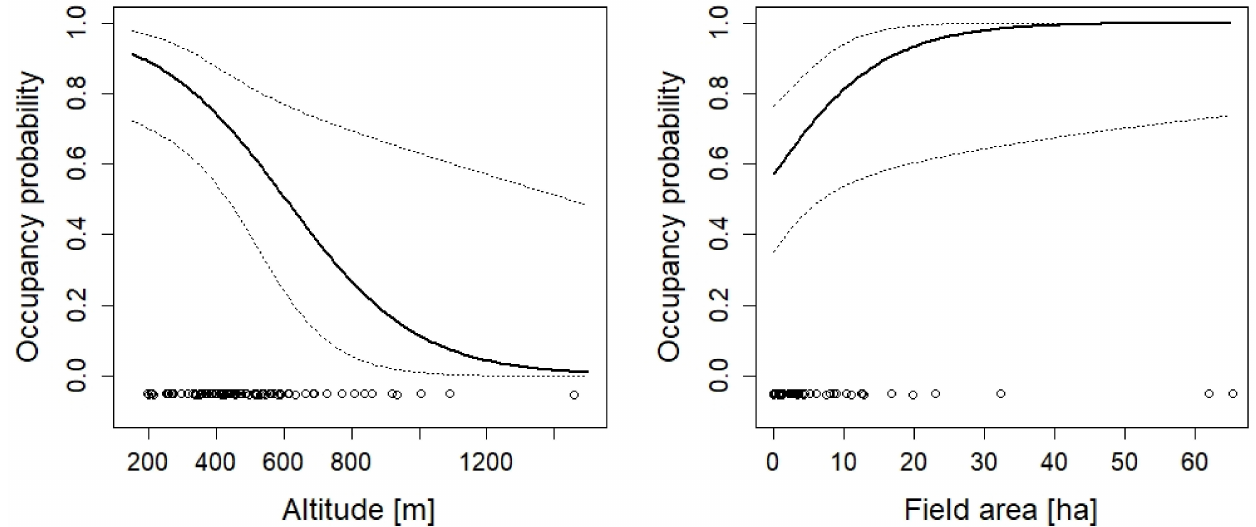
Figure 9. The effect of altitude and the area of fields on the occupancy probability of Rana dalmatina . For additional explanations, see the caption of Figure 2. The effect of connectivity is not shown because the confidence intervals widely overlap zero.